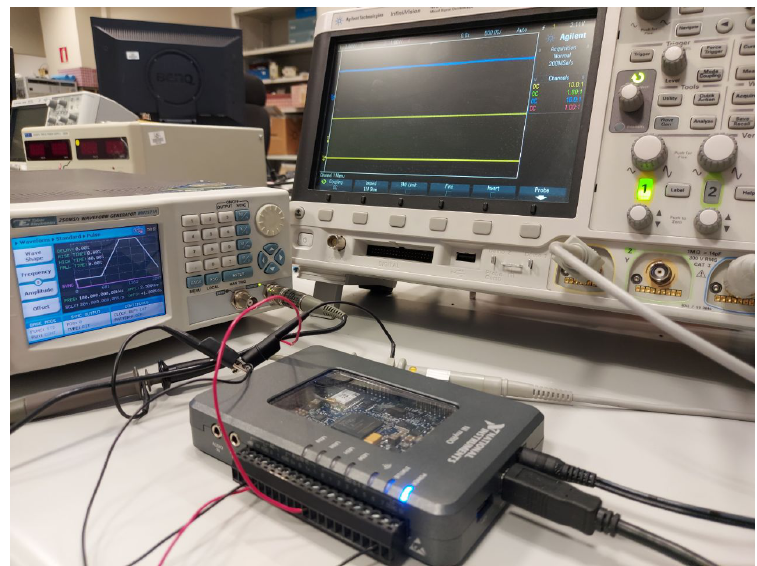
Figure 4. RT NI myRIO-1900 board constructed for implementing the models coded in G language.